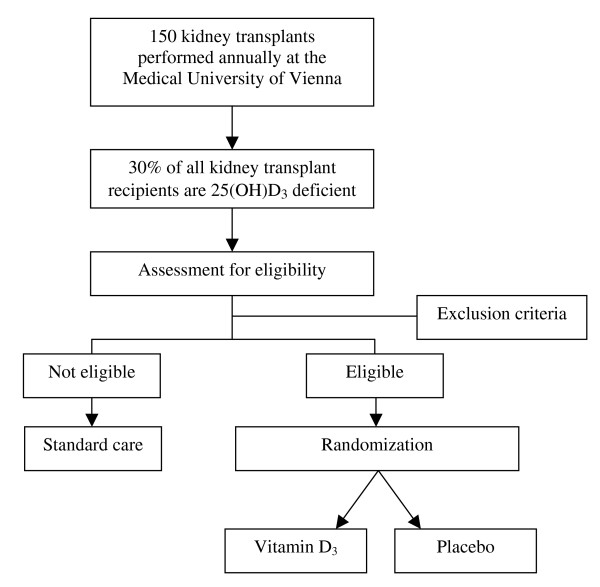
Flowchart of the VITA-D study.